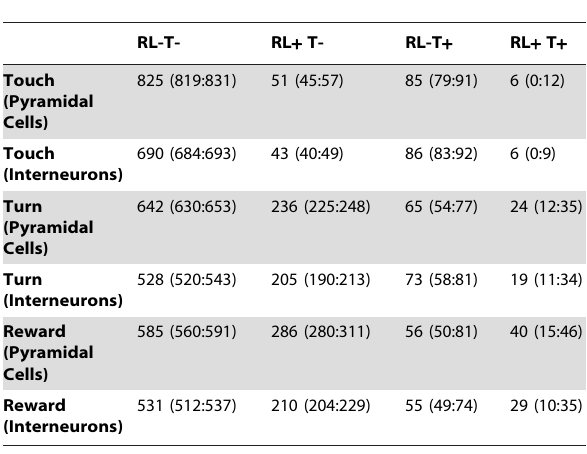
Table 1. Numbers of neurons that carry significant amount of information about the texture (T) and reward location (RL) in all possible combinations separately for putative interneurons and pyramidal cells during each phase of the task together with the 99,9 percent confidence intervals (in brackets) expected from independent representations of texture and reward